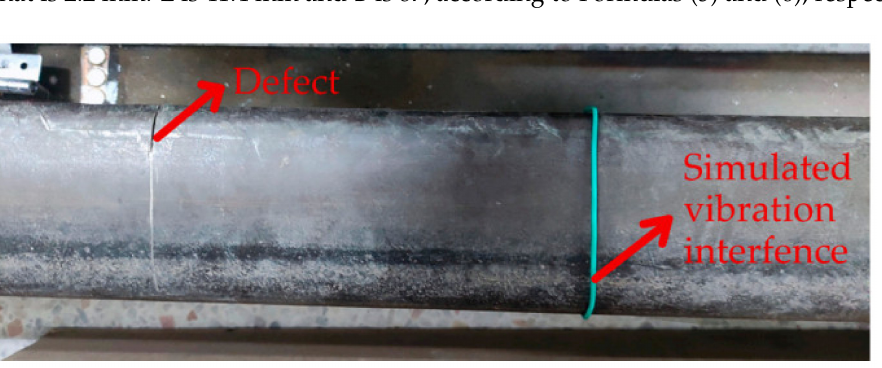
Figure 9. A rail with artificial defect.